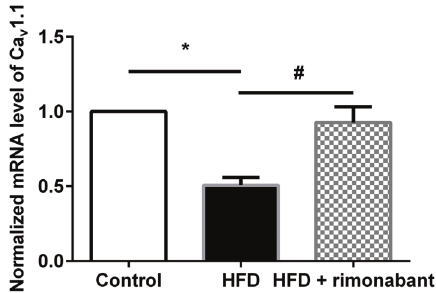
Figure 2. Expression levels of Ca v 1.1 in soleus muscle in regular diet (control; n=5), high-fat diet (HFD) and HFD + rimonabant groups. Data are reported as means ± SE. *P o 0.05, HFD vs control, # P o 0.05, HFD vs HFD + rimonabant (repeated mea- sures one-way ANOVA was used).